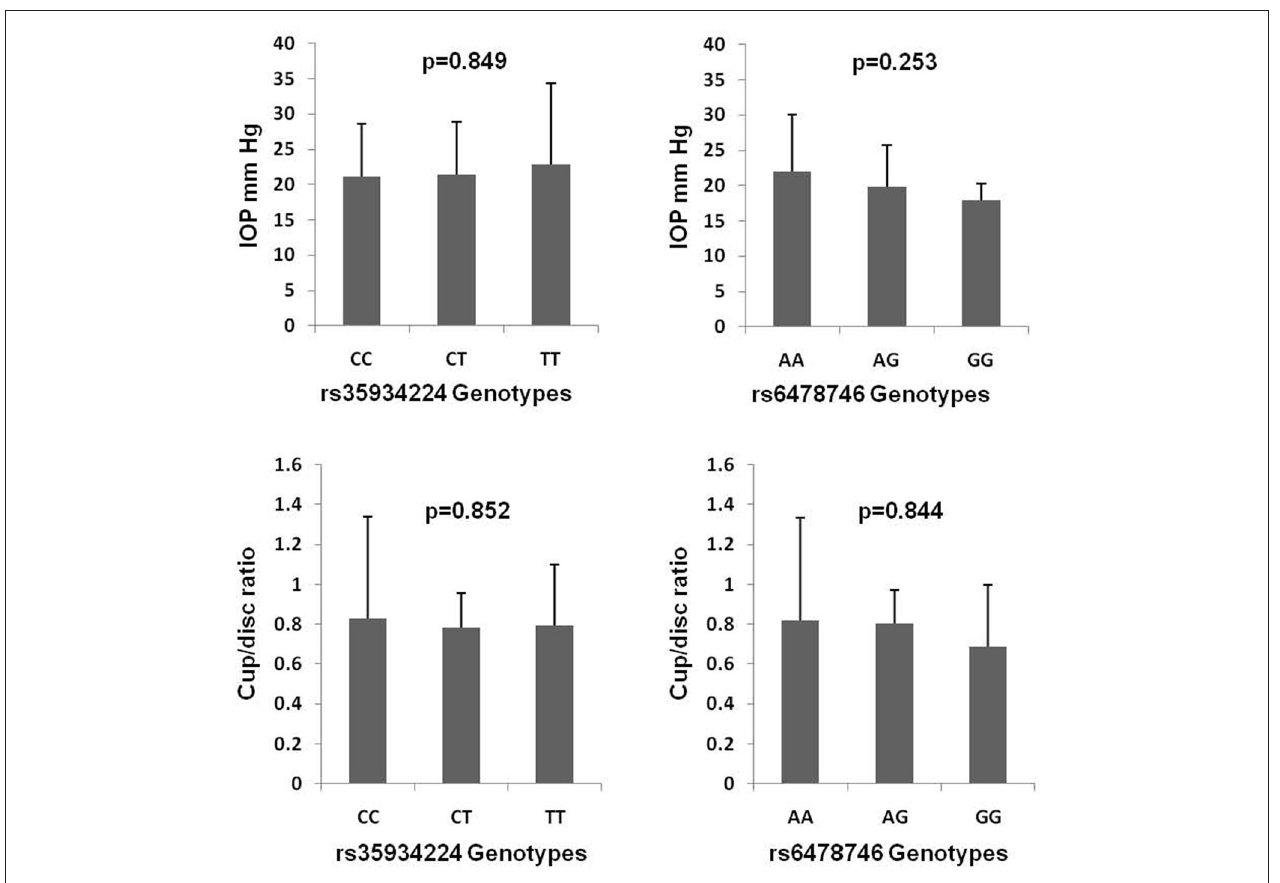
FIGURE 1 | Genotype effects of rs35934224 and rs6478746 variants on intraocular pressure (IOP) and cup/disc ratio in primary open-angle glaucoma. p -values are based on one-way ANOVA analysis.